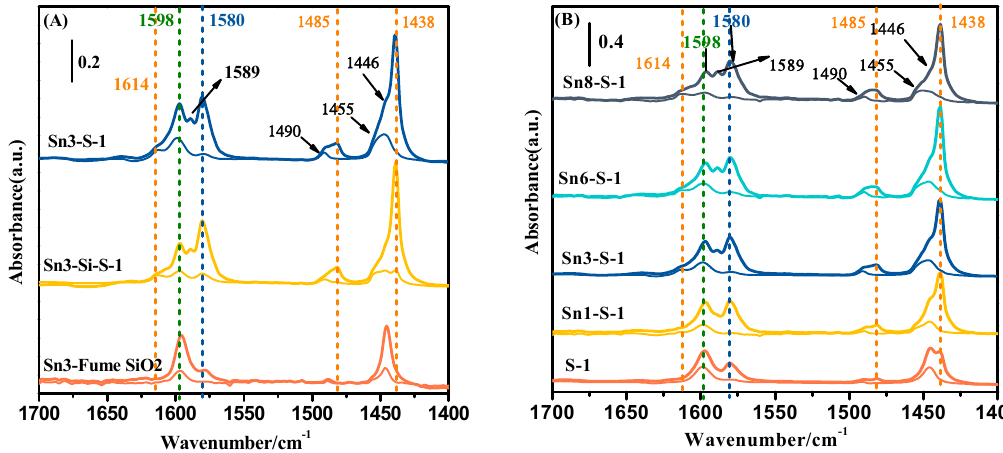
Figure 6. Pyridine adsorption FT-IR spectra of Sn-containing catalysts with different matrixes ( A ) and Sn-containing defective S-1 zeolite catalysts with different Sn loadings ( B ) (thick lines: evacuated at 200 °C; thin lines: evacuated at 350 °C).